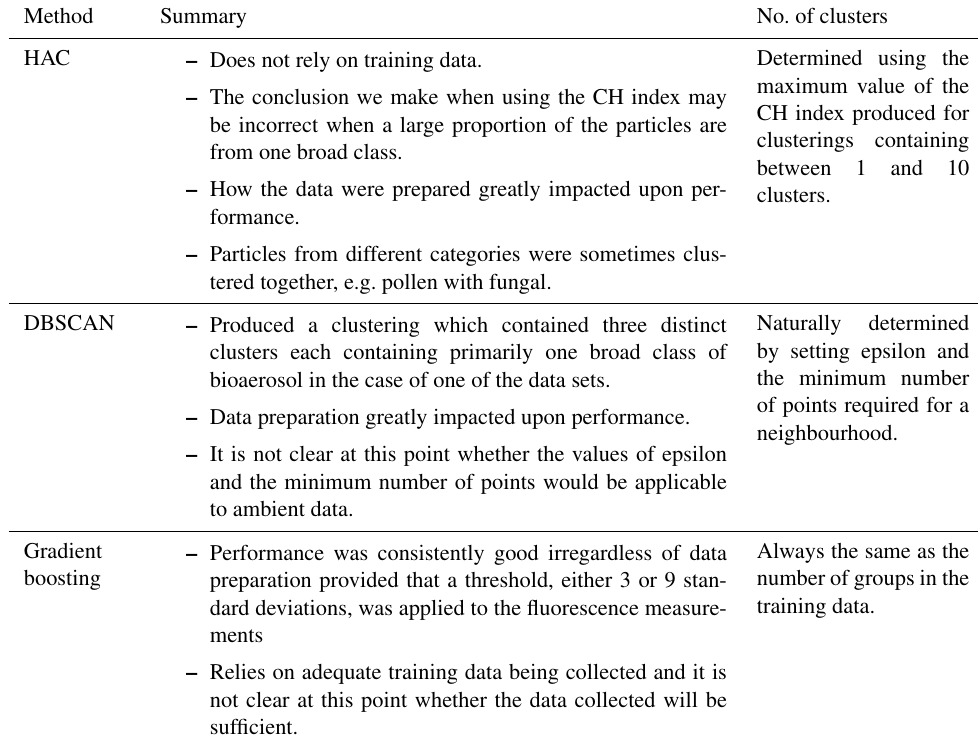
Table 4. Summary of findings and considerations for method selection.